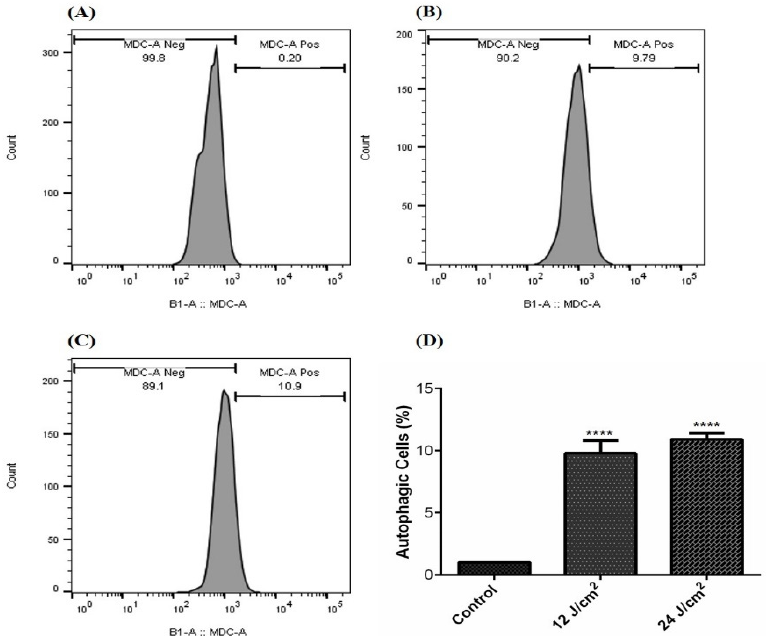
Figure 4. The percentage of autophagic cells following ZnPc-PDT; ( A ) control cells; ( B ) cells were treated with 12 J/cm 2 ; ( C ) cells were treated with 24 J/cm 2 ; ( D ) the results are expressed as mean ± SD ( n = 3); **** p < 0.0001 compared with control group.